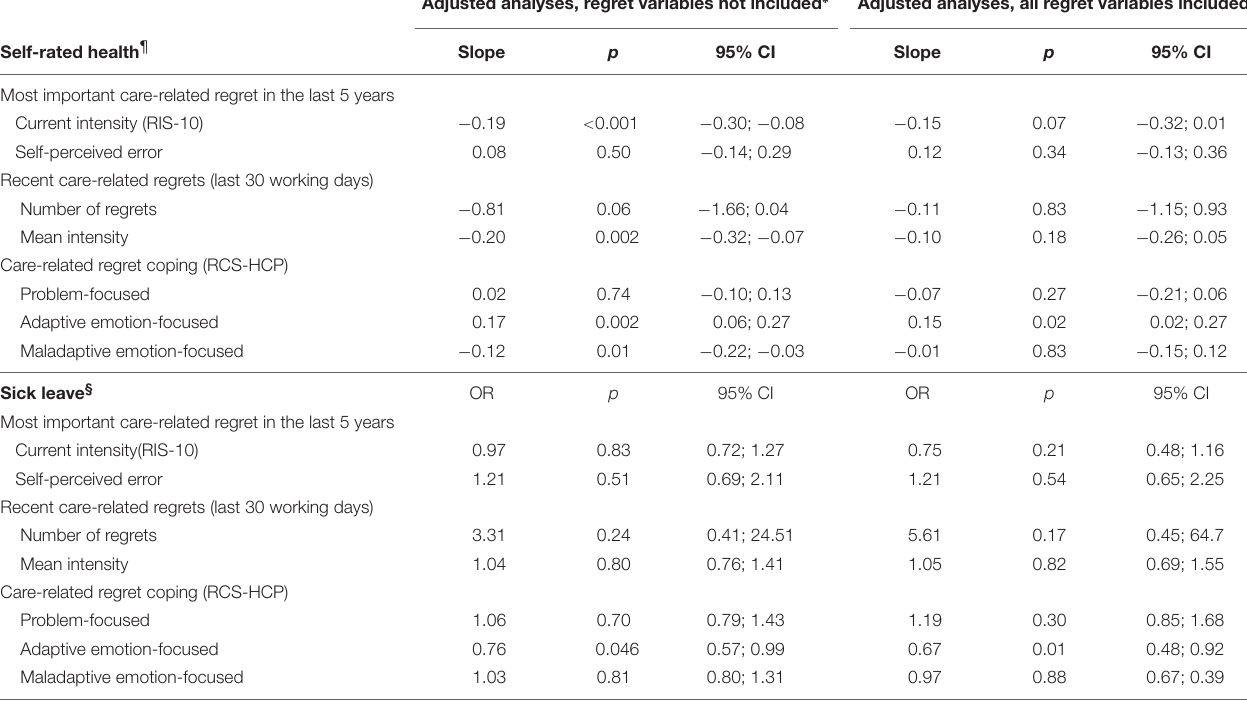
TABLE 3 | Association of care-related regret with health conditions among physicians. Adjusted analyses, regret variables not included ∗ Adjusted analyses, all regret variables included